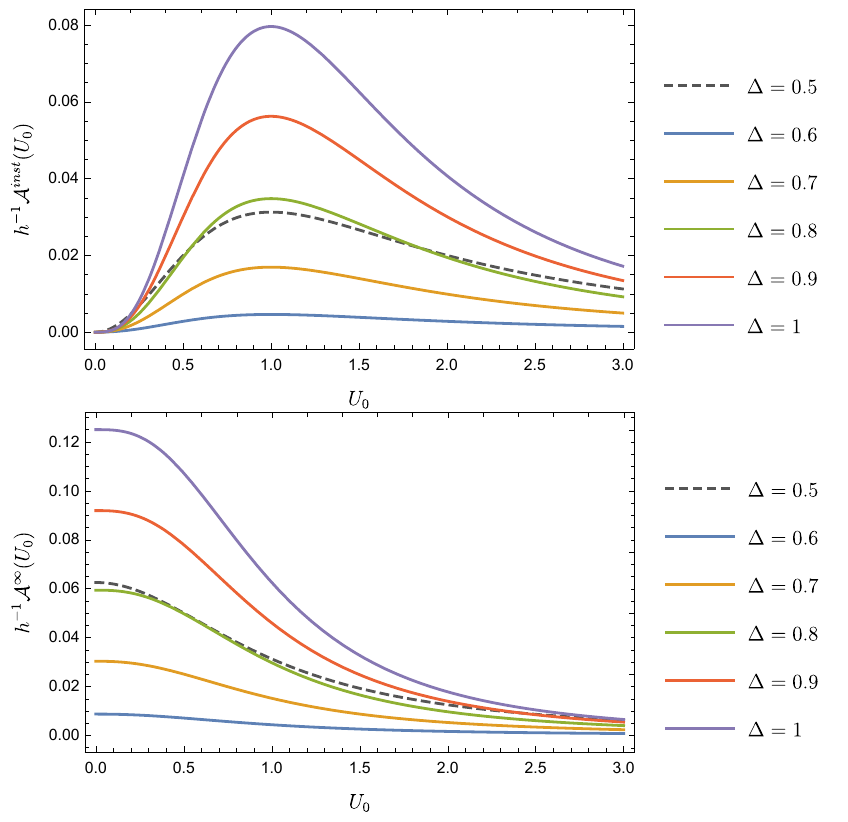
Figure 3 . The ANE as a function of U 0 for q = 0